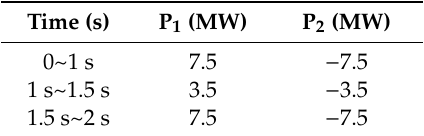
Table 1. The set values of both systems’ active